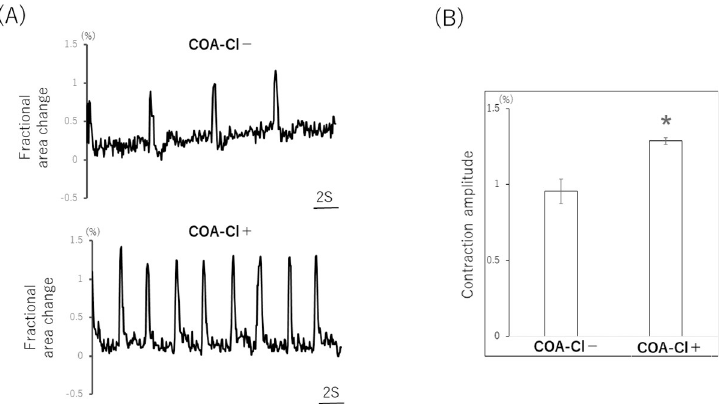
Fig 3. Cardiac organoids in bright-field images were observed on day 10. Representative contraction profiles of cardiac organoids were constructed based on a video analysis of the spheroid fractional area change (A). The analysis of the average ( ± SEM) contraction amplitude (i.e. fractional area change) showed significant differences on day 10 (n = 4 organoids). COA-Cl significantly increased the beating rate and the fractional area change in organoids (B). Asterisk indicates a statistically significant difference, p <